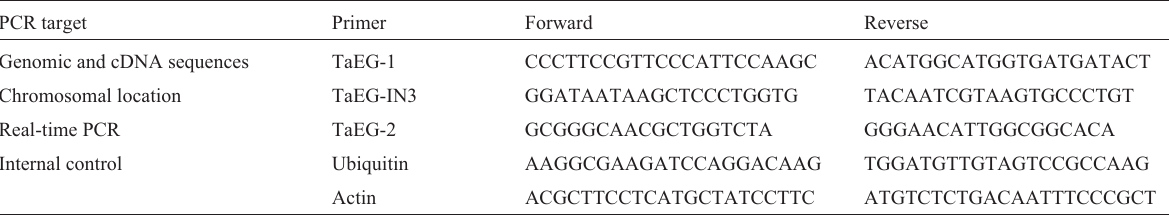
Table 1 - Primers used in this